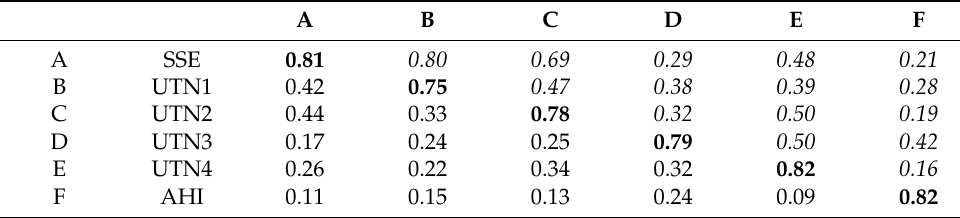
Table 5. Discriminant validity.